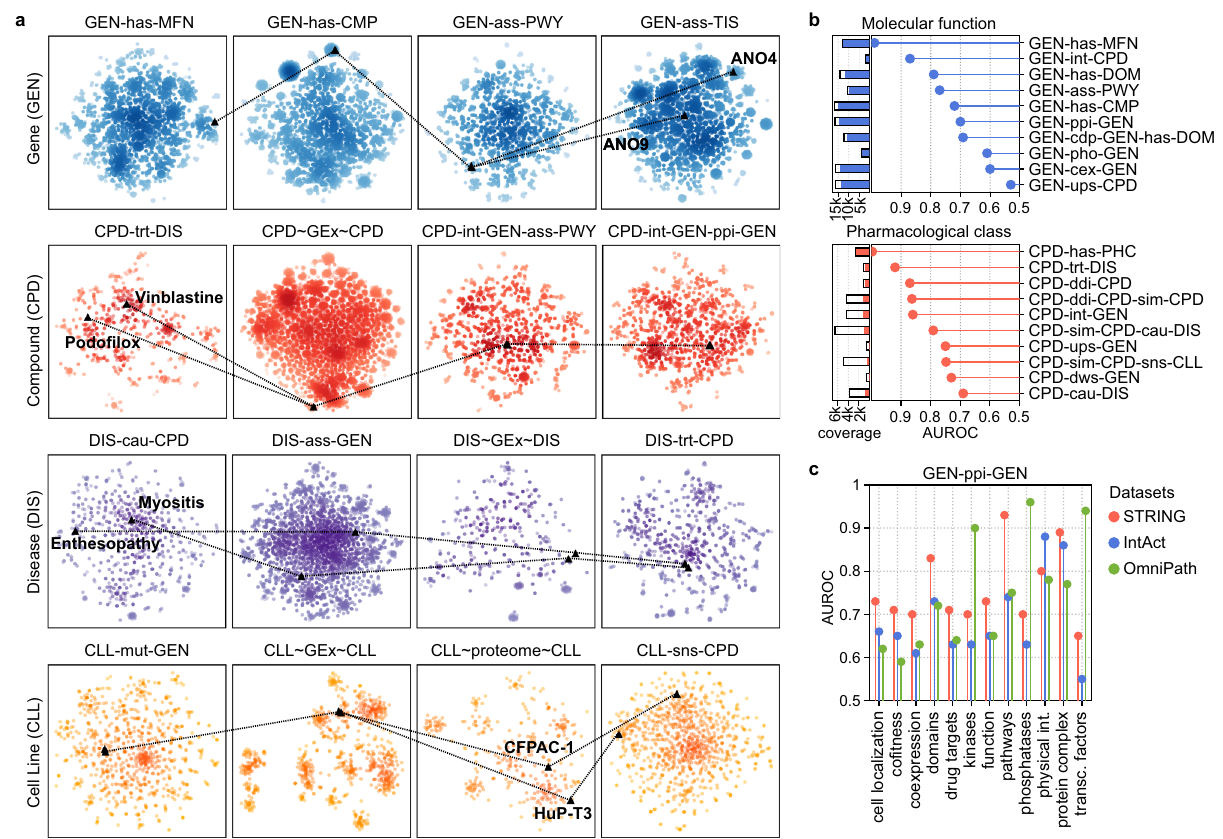
Fig. 4 | Comparison of embeddings built from different metapaths and data- sets.a Fourillustrativeexamplesshowingpairsofgenes(GEN),compounds(CPD), diseases(DIS) and cell lines (CLL) with similarities or differences depending on the metapaths. The extended nomenclature of each metapath can be found in Sup- plementary Data 2. b Top metapaths (y-axis) recapitulating (AUROC, x-axis) gene molecular function (MFN, blue) and compound pharmacological class (PHC, red).